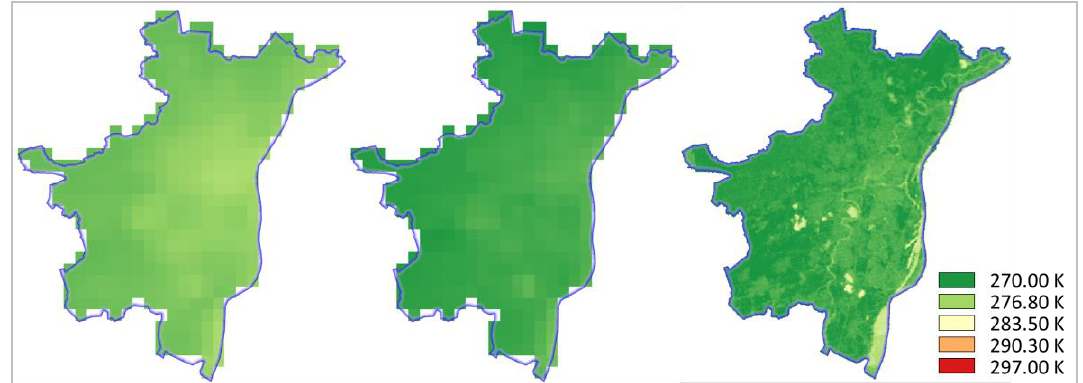
Figure 10 . Winter UHI map of Strasbourg at night when analysing all data from MODIS (left), typical days from MODIS (center), and the available data from ASTER (right)